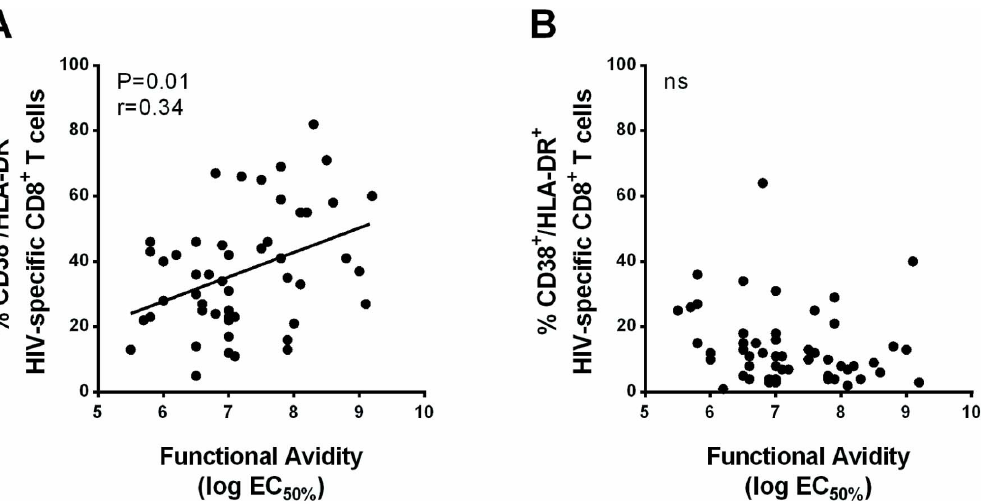
Figure 6. High antigen sensitivity is associated with a high frequency of CD38 2 /HLA-DR + cells in HIC. The antigen sensitivity of HIV- specific CD8 + T cells was measured in ELISpot assays with serial limiting dilutions of antigenic peptides (from 10 2 5 to 10 2 11 M) and was expressed as the log molar concentration of peptide yielding 50% of the maximum response (EC 50% ). Correlations between the proportion of CD38 2 /HLA-DR + (A) or CD38 + /HLA-DR + (B) and the antigen sensitivity of HIV-specific CD8 + T cells from HIC. Correlations were evaluated using the Spearman rank correlation coefficient. The Spearman r correlation and the Pearson correlation curve are indicated for significant correlations (n=47).